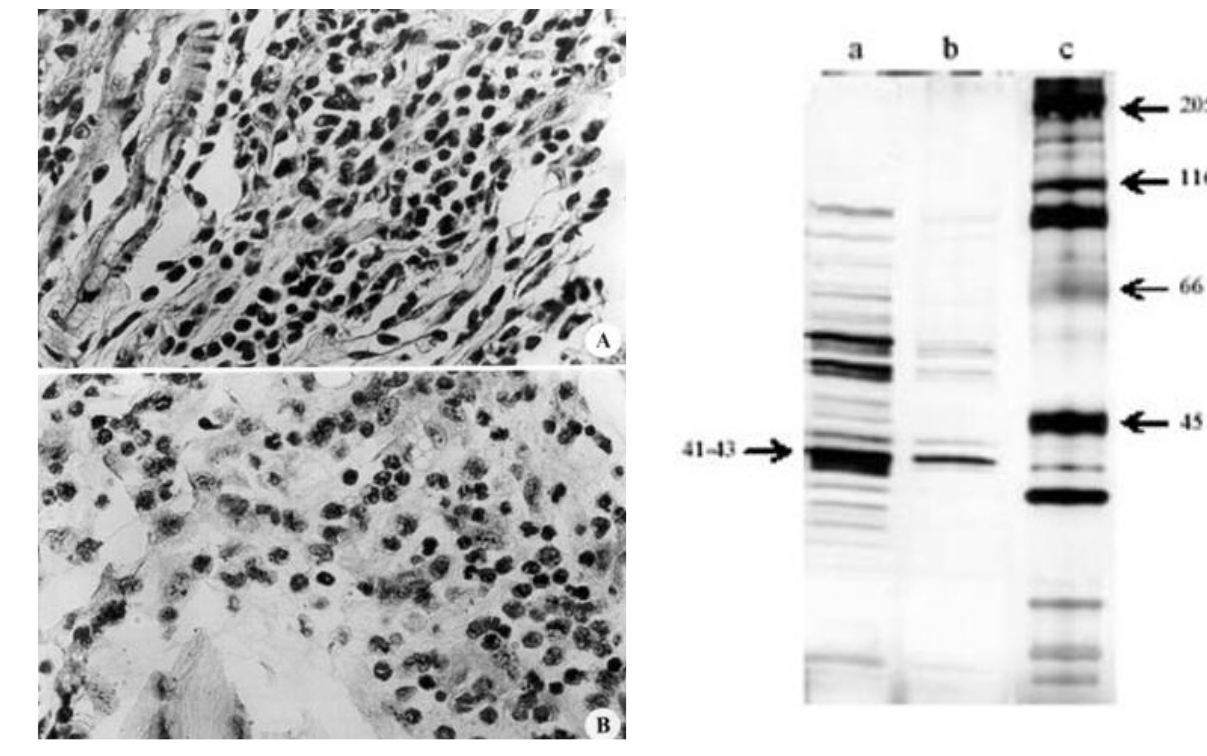
Figure 2. Histopathological analysis of DTH reactions induced by 4d CFAg and 11d CFAg. Fifteen days after IP infection with P. brasiliensis 265, mice were challenged via the footpad with CFAg. Twenty-four hours later, footpad sections were stained and analyzed. ( A ) Four-day CFAg showing predominance of mononuclear cells (HE 100x) and ( B ) Eleven-day CFAg showing predominance of polymorphonuclear cells (HE 100x).